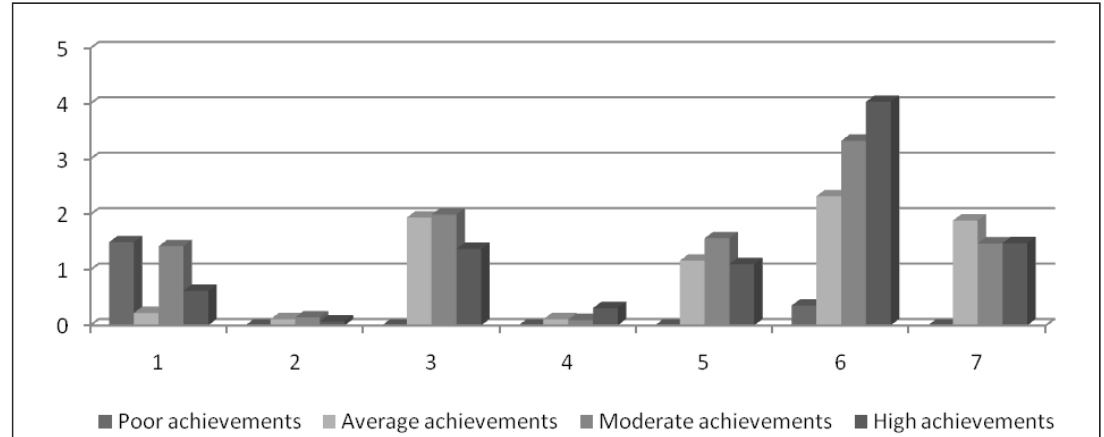
Fig.1. Life planning in the domains from causometric interview in the four samples